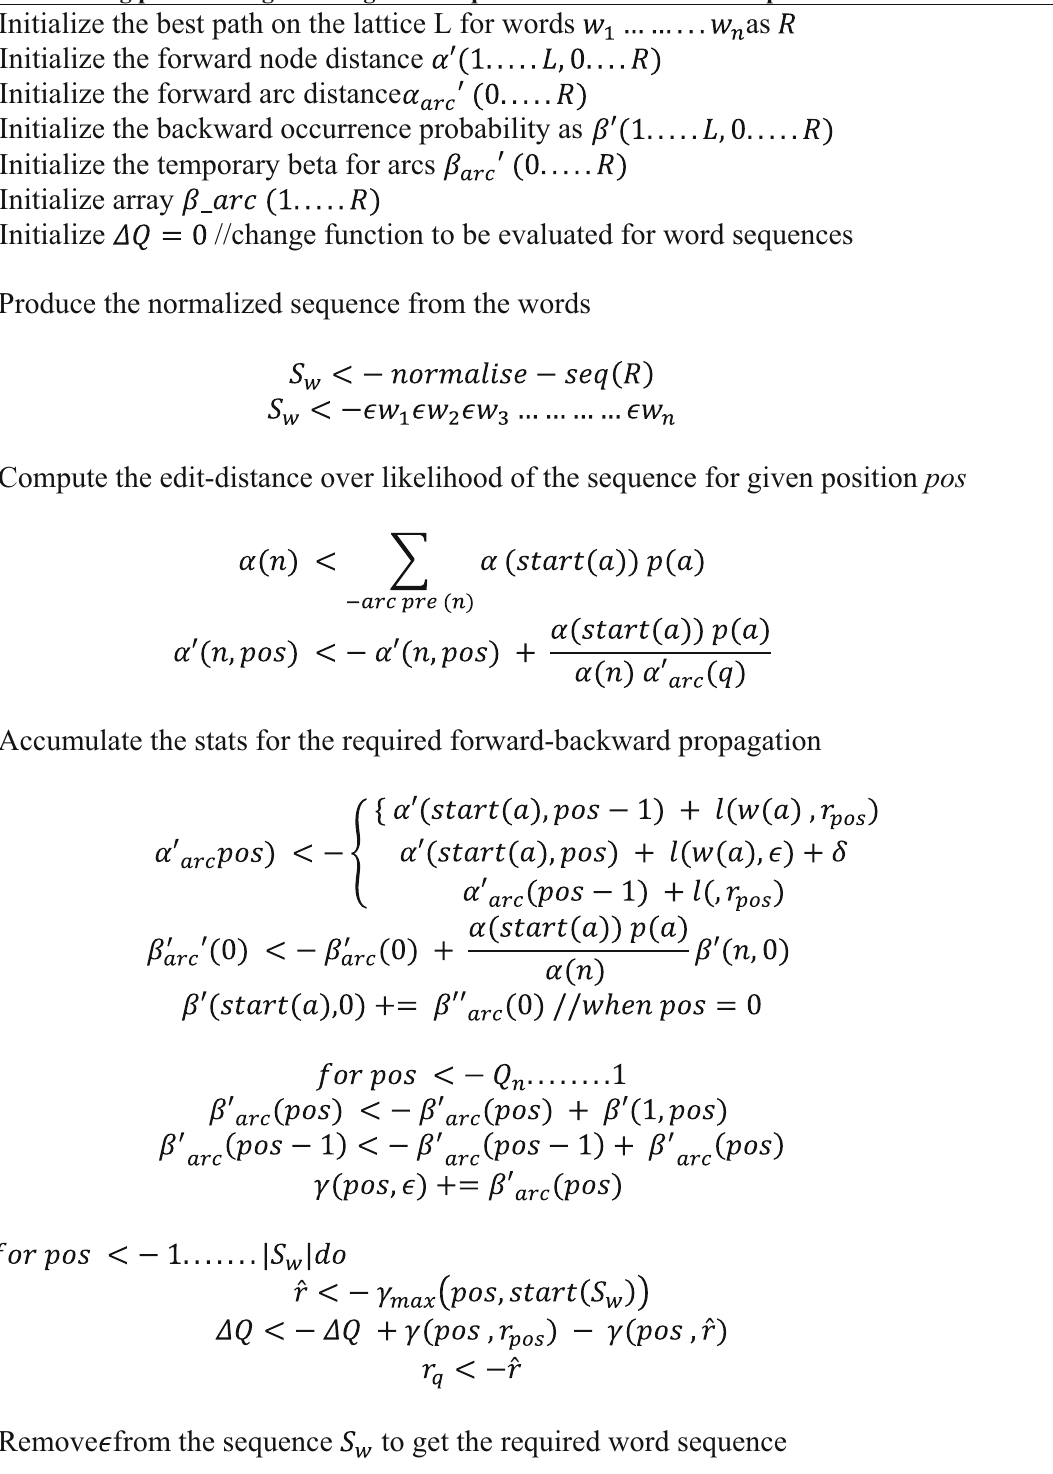
Algorithm 2: Decoding process for generating word sequences based on the lattice